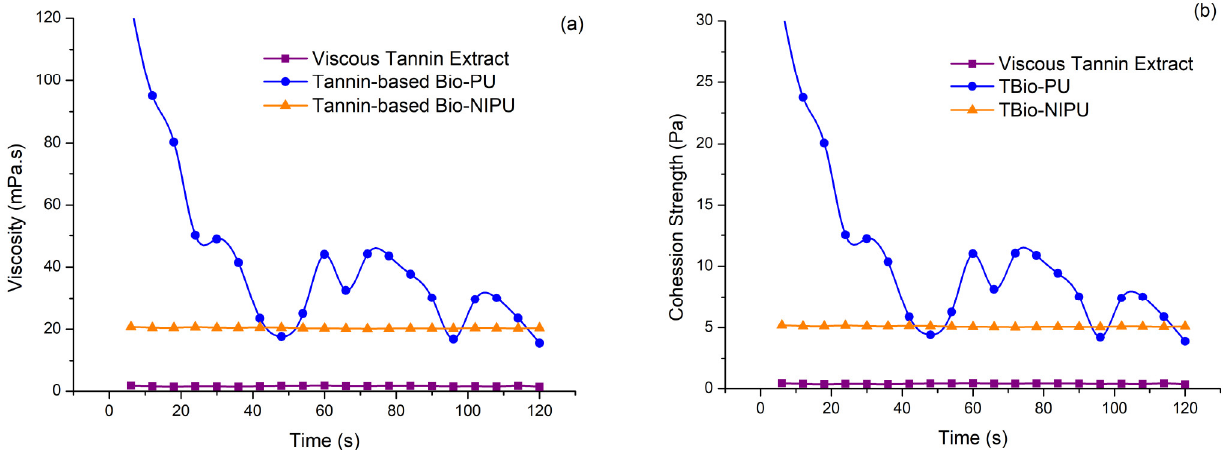
Figure 5. Physicochemical properties: ( a ) viscosity; ( b ) cohesion strength